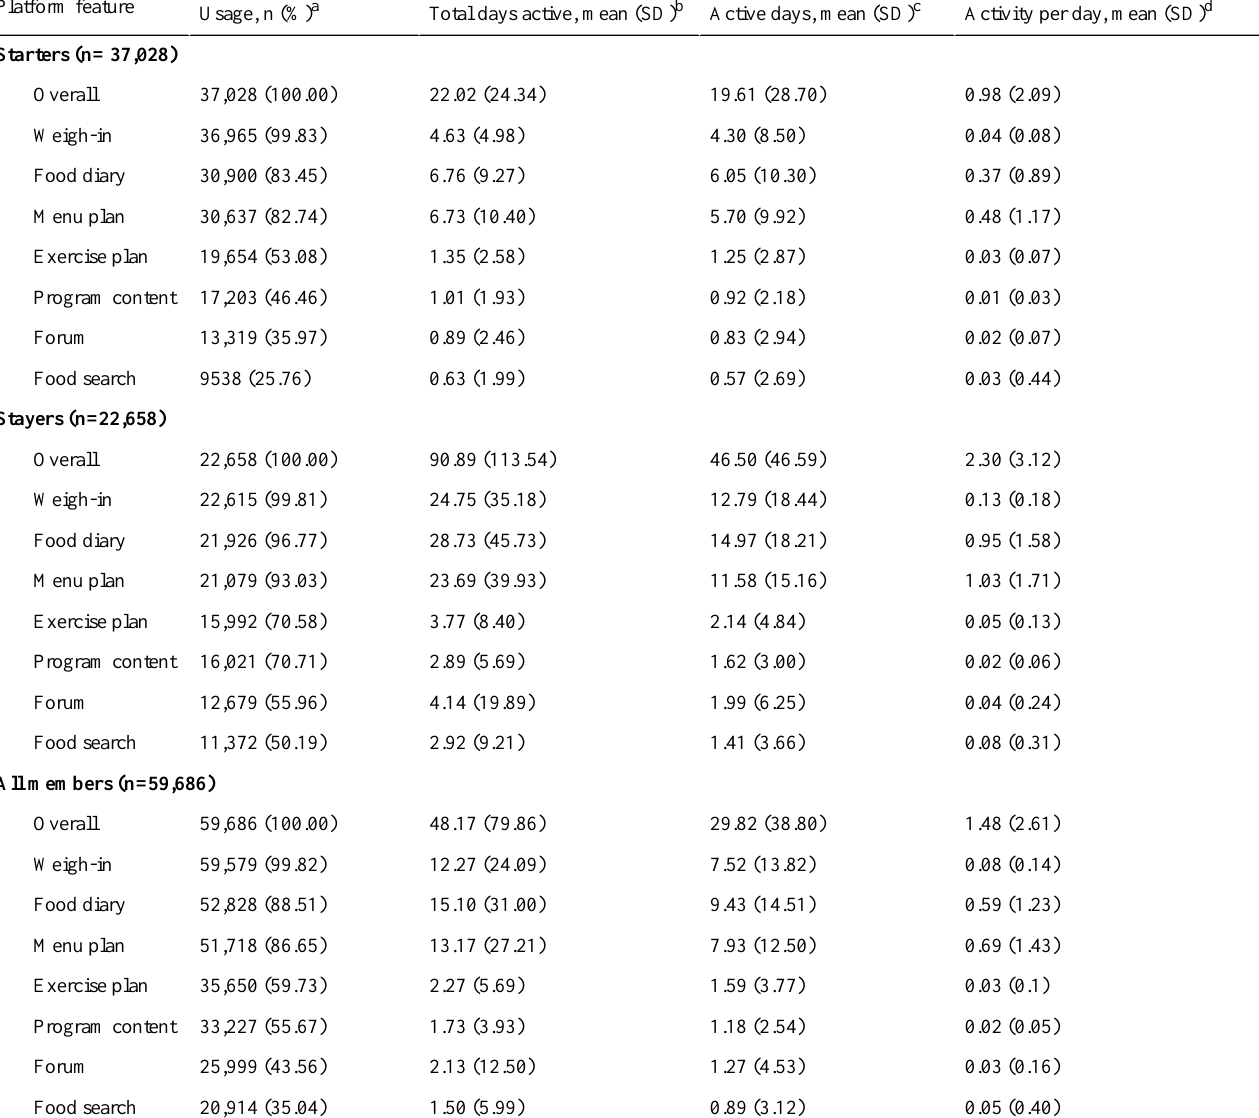
Table 5. Platform feature usage for starters (n=37,028), stayers (n=22,658) and all members (n=59,686) of the CSIRO Total Wellbeing Diet